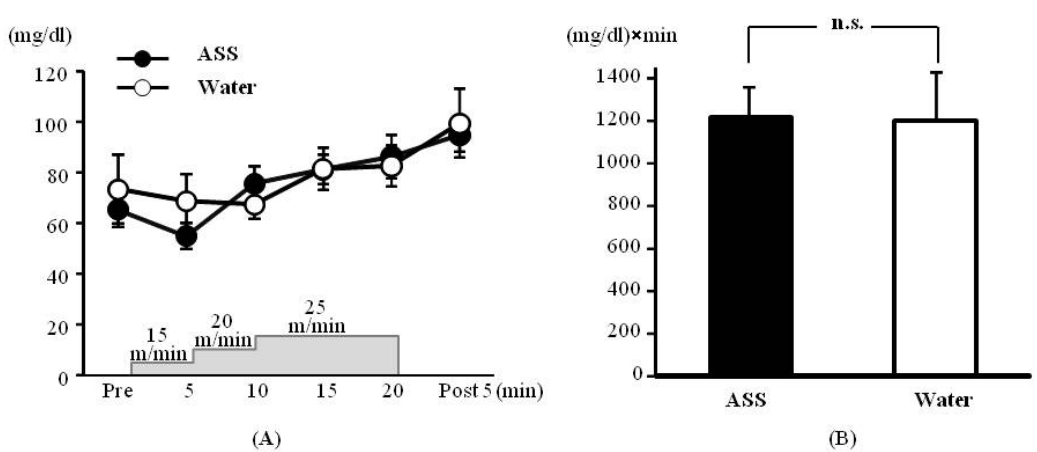
Figure 2. Changes in the blood glucose on incremental treadmill exercise. ( A ) time course change, x axis: elapsed time on running, y axis: blood glucose concentration ( B ) area under the curve of blood lactate acid, x axis; group, y axis: total volume of blood glucose. Values are expressed as mean ± SE. n.s.: no significant differences.